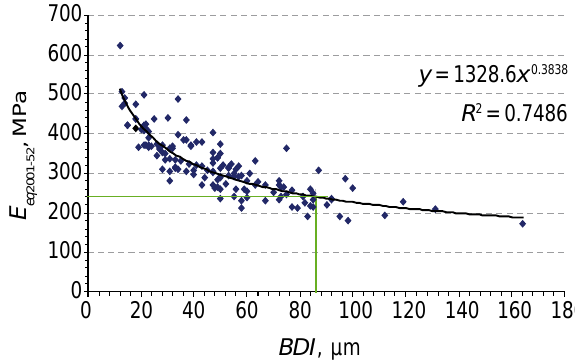
Fig. 3. E eq 2001-52 – BDI, AC , analyze group 6, without surface defects